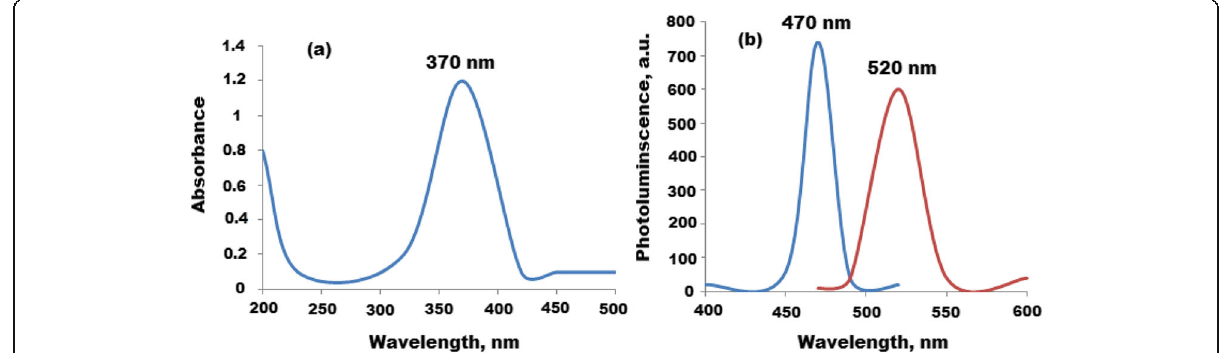
Fig. 4 Spectroscopic spectra of CQDs/ZnONPs a UV-Vis spectrum at absorption peak at 370 nm and b photoluminescence spectrum of CQDs/ ZnONPs at λ ex = 470 and λ em = 520 nm